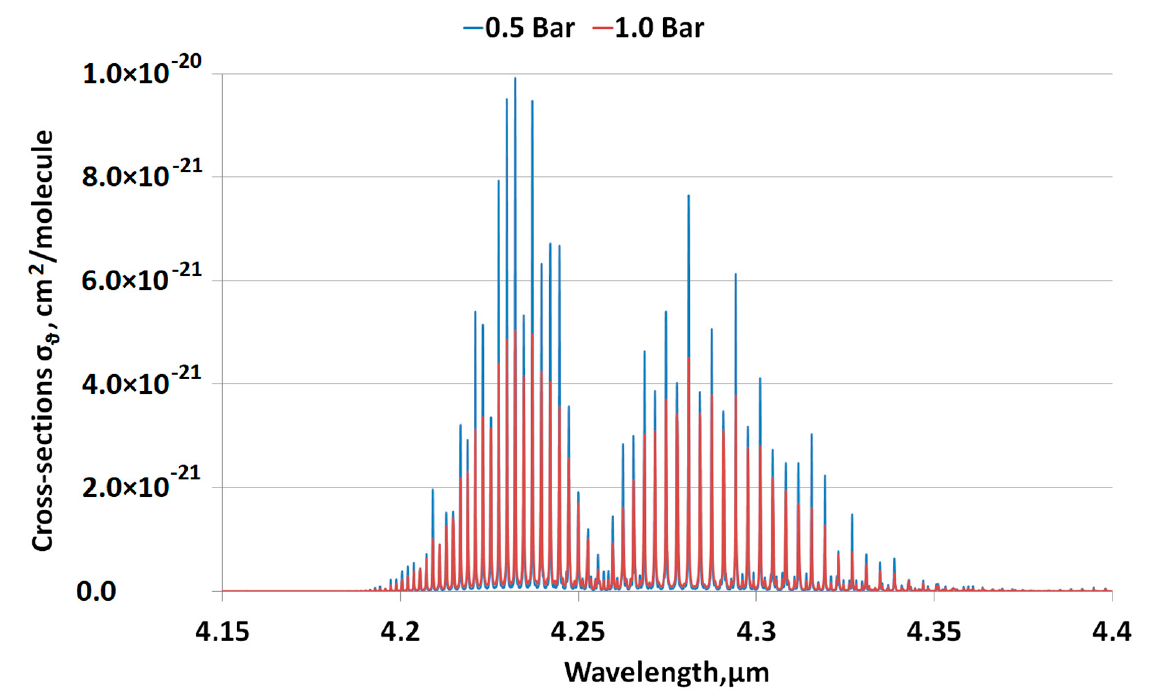
Figure 2. Simulation of absorption cross section σ ϑ for two pressure levels 0.5 and 1.0 Bar at a concentration of 400 ppm CO 2 and a temperature of 296 K. A variation in ambient pressure leads to a variation in absorption capacity.